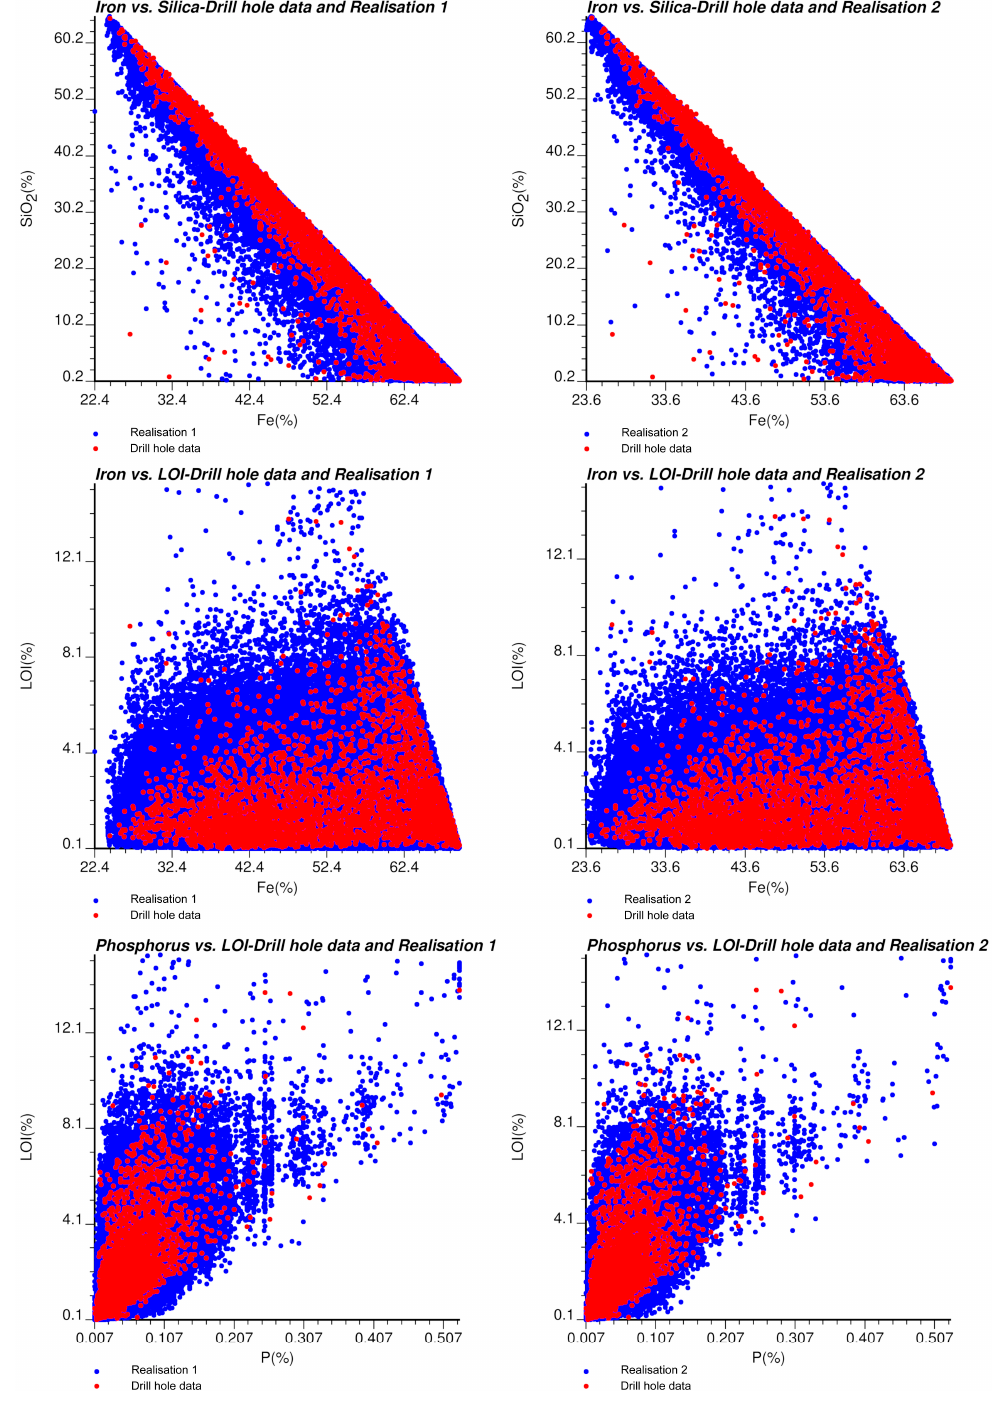
Figure 5. Scatter diagrams of Fe vs. SiO 2 , Fe vs. LOI, and LOI vs. P for drill hole data (red) and simulated values (blue). Left : realisation 1, right : realisation 2.